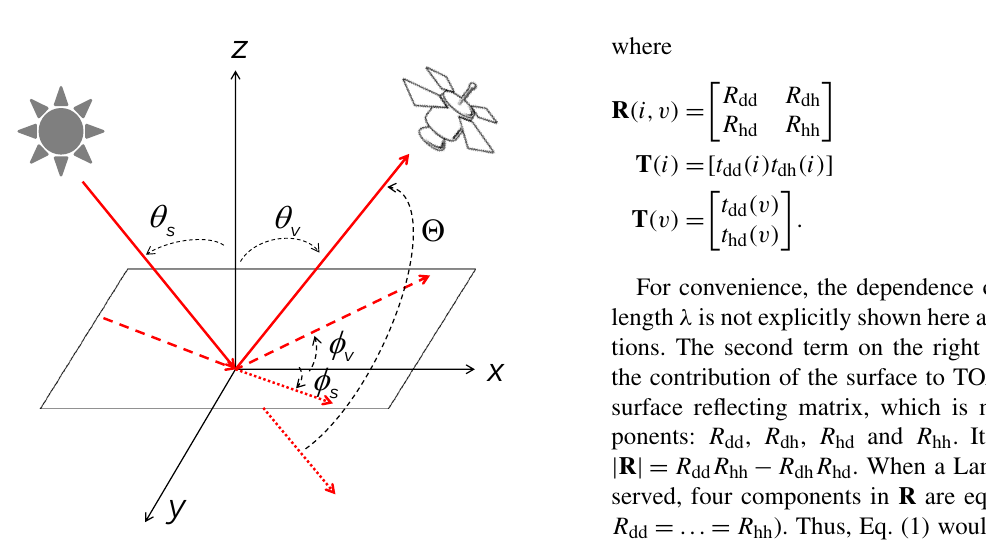
Figure 1. Schematic of illumination and viewing geometry on the surface target. The red solid lines (black dash curves) indicate the directions of the incident and reflected radiation, which are de- scribed as solar zenith angle θ s and viewing zenith angle θ v (mea- sured from the zenith direction z ) and solar azimuth angle φ s and viewing azimuth angle φ v (measured from the horizontal direc- tion x ). The dotted red lines represent the extension of the direction of the incident radiation. The scattering angle (cid:50) is given as the an- gle between the direction of the incident radiation and the one of the reflected radiation received by the